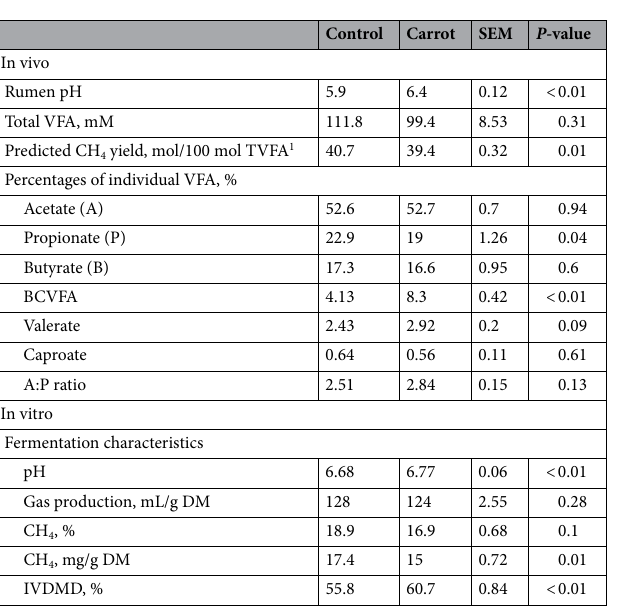
Table 1. Volatile fatty acid (VFA) profile and pH of rumen fluid obtained post-slaughter from lambs fed a control or carrot diet. In vitro fermentation characteristics, CH 4 production and dry matter digestibility of diets determined using rumen fluid obtained from cannulated Holstein steers. SEM standard error of the mean, IVDMD in vitro dry matter digestibility, BCVFA branch-chained volatile fatty acids (iso-valerate + iso- butyrate). 1 CH 4 yield = 0.50A + 0.25P + 0.50B (Williams et al. 18